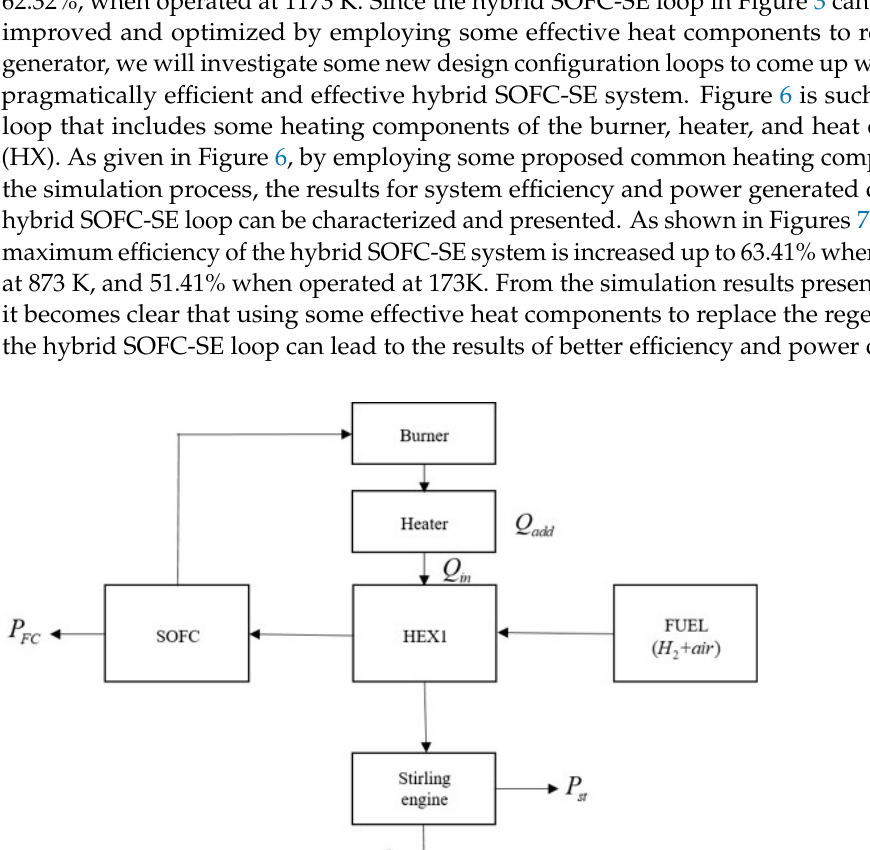
Figure 5. Computed ( a ) efficiency and ( b ) generated power for different current densities at 1173 K for the hybrid SOFC-SE system without heat components (Emin [20]).